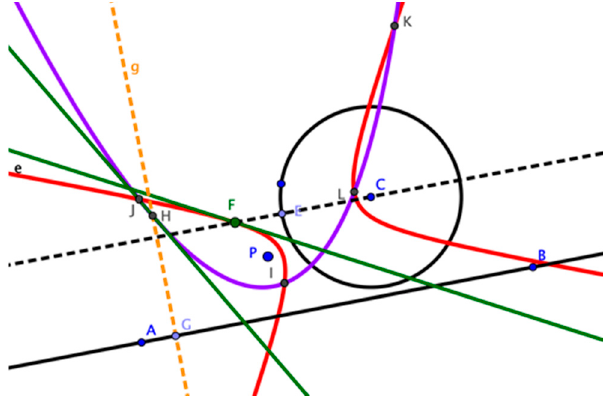
Figure 9. The loci of points F and H are conic sections. Based on Figure 9, the intersection points of the hyperbola and parabola (I, J, K & L) are the centers of circles that meet the problem conditions with radii IP, JP, KP & LP, respectively (Figure 10).